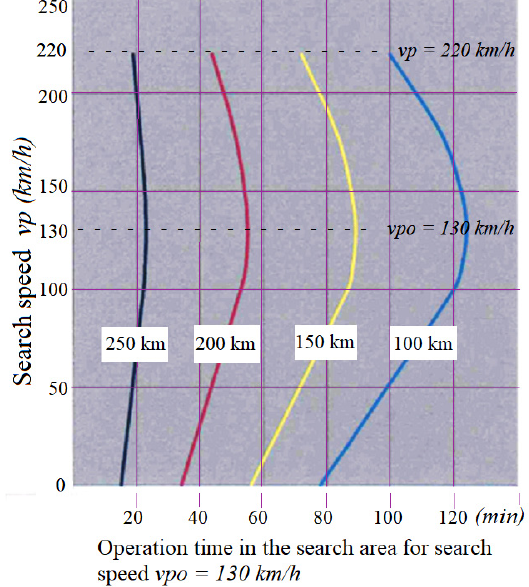
Figure 4. Dependence of the operation time in the search area depending on the search speed vpo achieved by the helicopter; optimal search speed is vpo = 130 km/h, constant cruising speed of the helicopter vp = 220 km/h and the set of search radius rp = (100, 150, 200, 250 km). Table 5. Dependence of flight time and working time on cruise speed at search speed vpo = 130 km/h. Radius rp